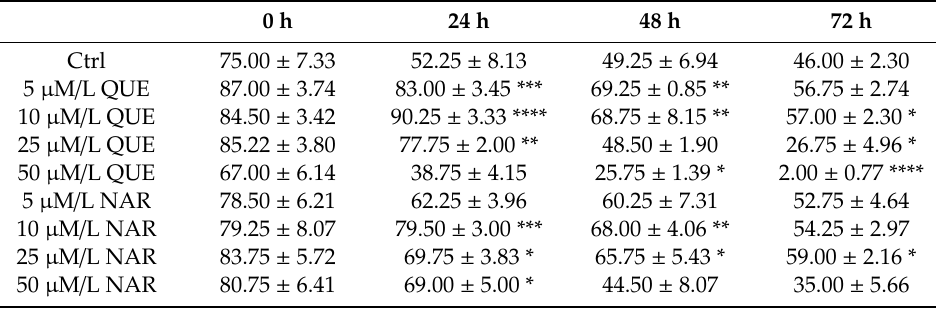
Table 1. Boar sperm motility (%) following exposure to quercetin or naringenin ( n =